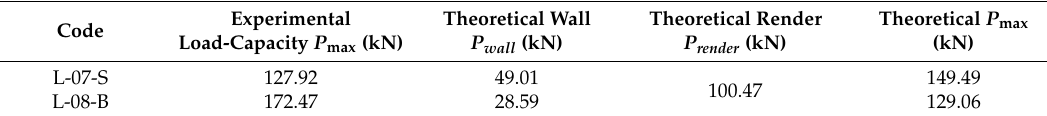
Table 5. Results of shear